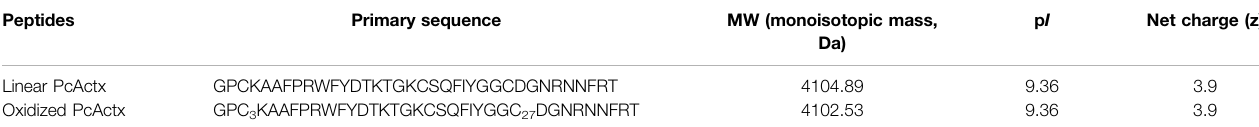
TABLE 1 | Primary sequences and physicochemical characteristics of the PcActx peptides. Peptides